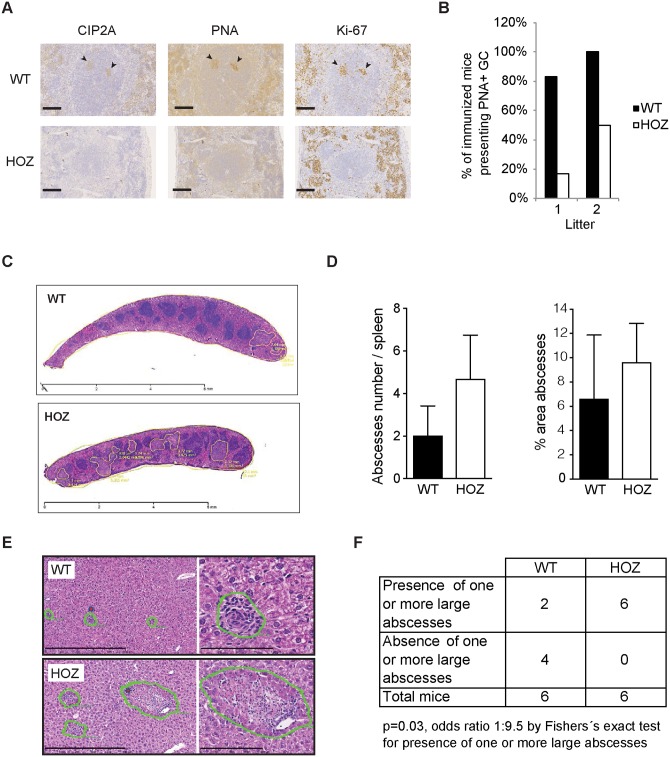
Impaired adaptive immune response in CIP2A deficient mice.(A) Immunohistochemical staining for CIP2A, germinal center marker peanut agglutinin (PNA), and proliferation marker Ki-67 in spleen from immunized WT and CIP2AHOZ mice. Arrows indicate positive staining of germinal center of indicated antigens in WT tissues. Scale bar represents 100 μm. (B) Percentage of immunized mice presenting a PNA positive staining in germinal center from two independent mouse cohorts of 6 WT and 6 CIP2AHOZ females, and 7 WT and 6 CIP2AHOZ females respectively. (C) Haematoxilin histological staining of spleen after primary infection with L.m. Bacterial abscesses are highlighted in yellow. Scale bar: 6 mm. (D) Abscesses number and percentage of the abscesses area compared to spleen total area after L.m. primary infection. Average of 2 WT and 3 CIP2AHOZ females is shown. Mann-Whitney t test. (E) Hematoxilin-eosin histological staining of liver presenting inflammatory lesions developed in response to second infection with intracellular bacteria L.m (5 days post recall infection). The right panels present higher amplifications of the lesions on the left. Scale bar represents 500 μm (left panel) or 100 μm (right panel). Representative pictures of 6 WT and 6 CIP2AHOZ females analyzed. (F) Quantitative and statistical analysis of the number of large abscesses (> 10 μm2) as described in (E).